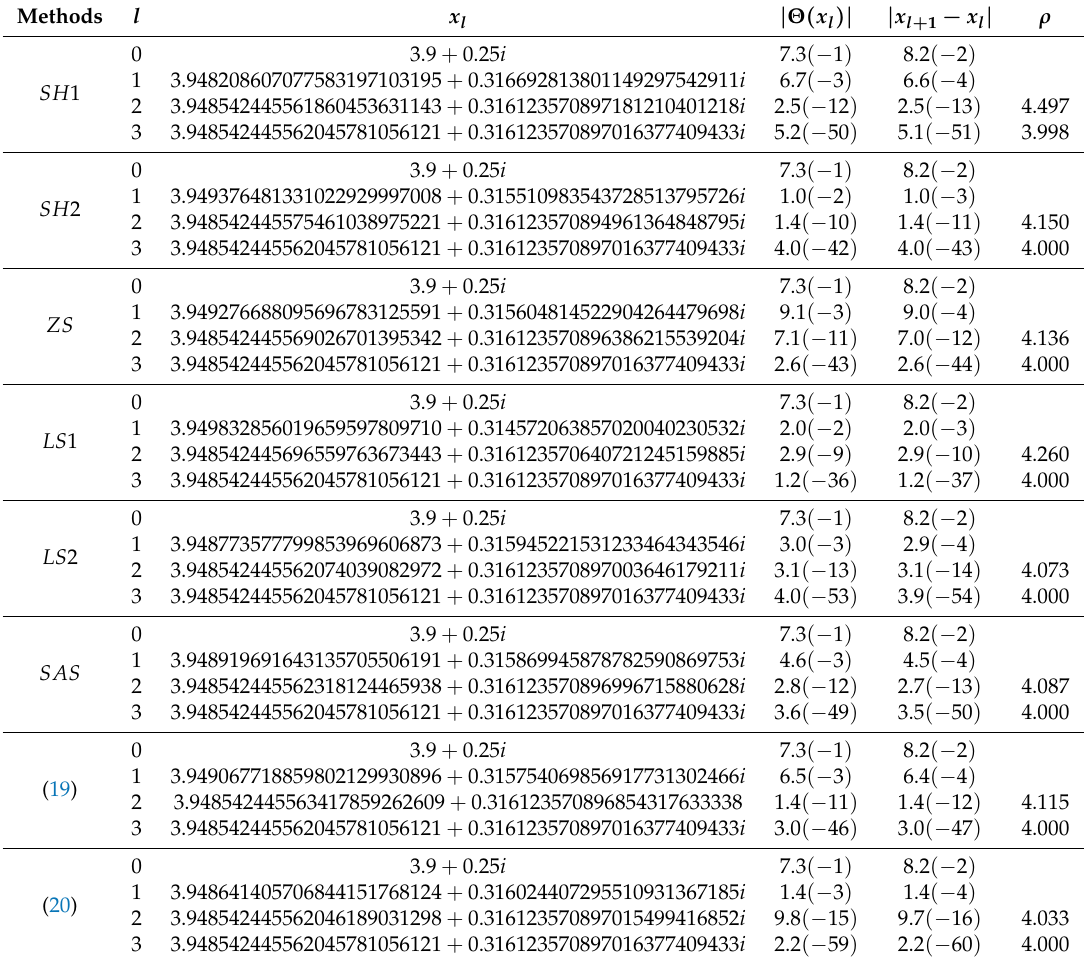
Table 3. Convergence study of distinct iterative functions on Θ 3 ( x )